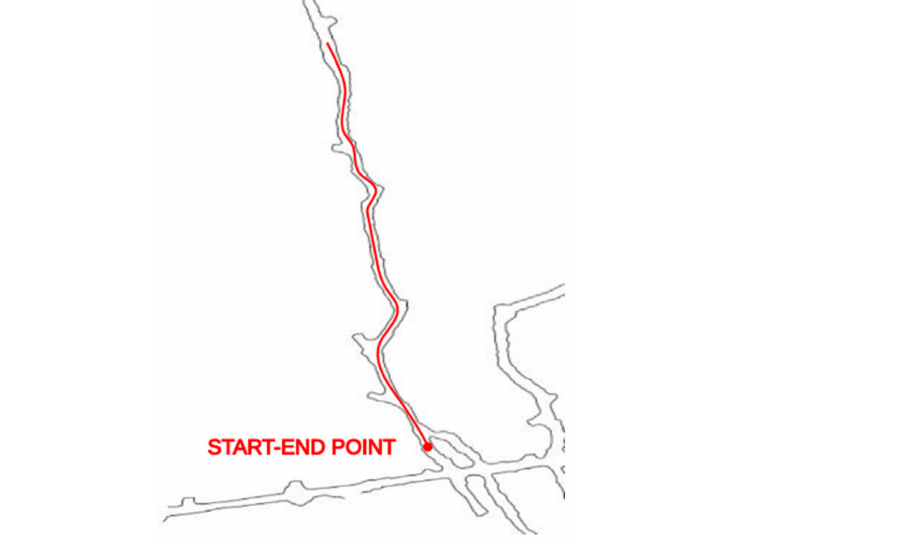
Figure 21. Layout of the mine’s tunnel where experiments were carried out.